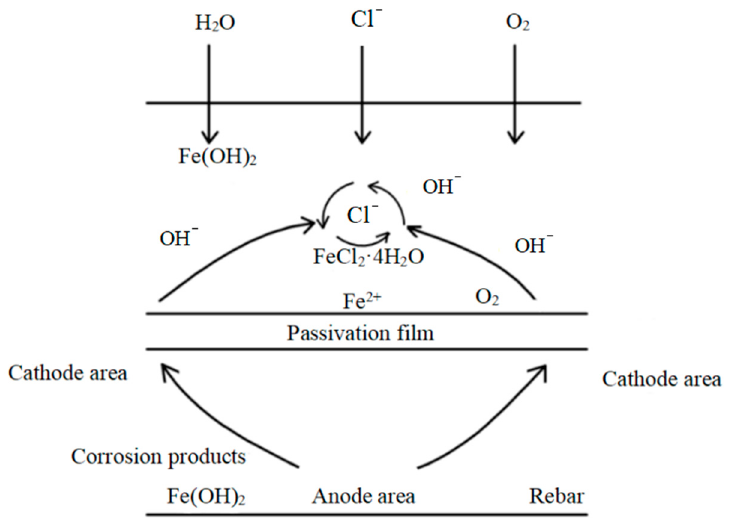
Figure 15. Corrosion diagram of reinforced concrete.